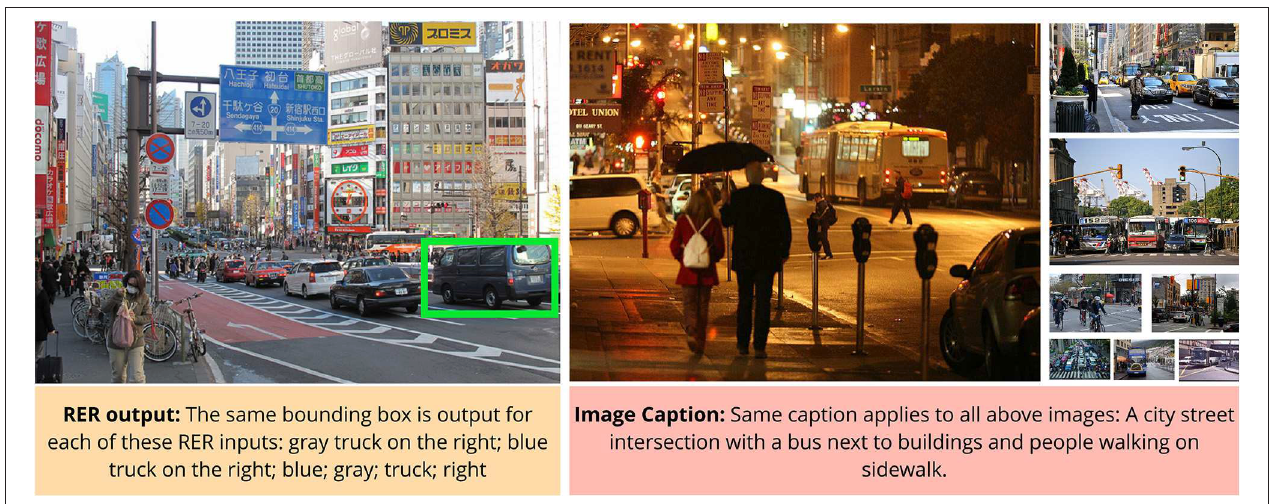
FIGURE 3 | The apparent vs. true complexity of V&L tasks. In RER (left) , omitting a large amount of text has no effect on the output of the system (Yu et al., 2018). Similarly, a seemingly detailed caption (right) can apply to a large number of images from the dataset making it easy to “guess” based on shallow correlations. While it appears as though the captioning system can identify objects (“bus,” “building,” “people”), spatial relationships (“next to,” “on”), and activities (“walking”). However, it is entirely possible for the captioning system to have ‘guessed’ the caption by detection of one of the objects in the caption, e.g., a “bus” or even a common latent object such as “traffic